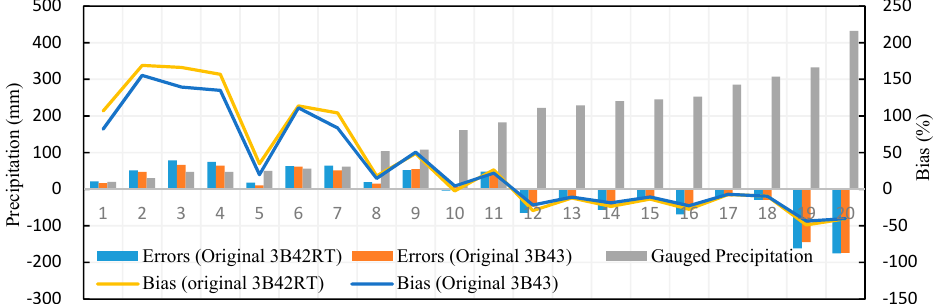
Figure 3. The Original TRMM Precipitation Products Errors.